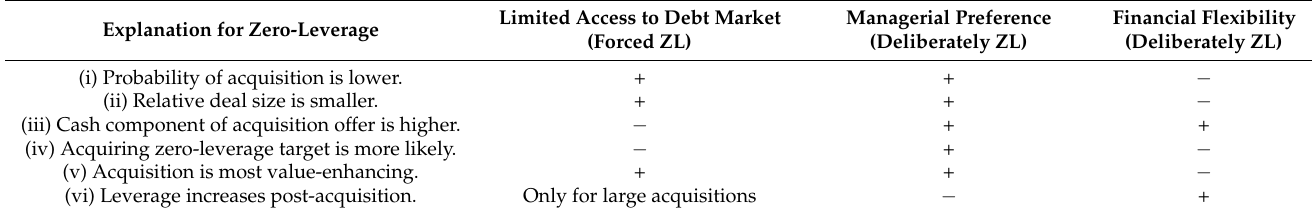
Table 1. Summary of the empirical predictions of the three hypotheses we considered. In the table, “ − ” indicates that the prediction is not supported, and “+” indicates that it is